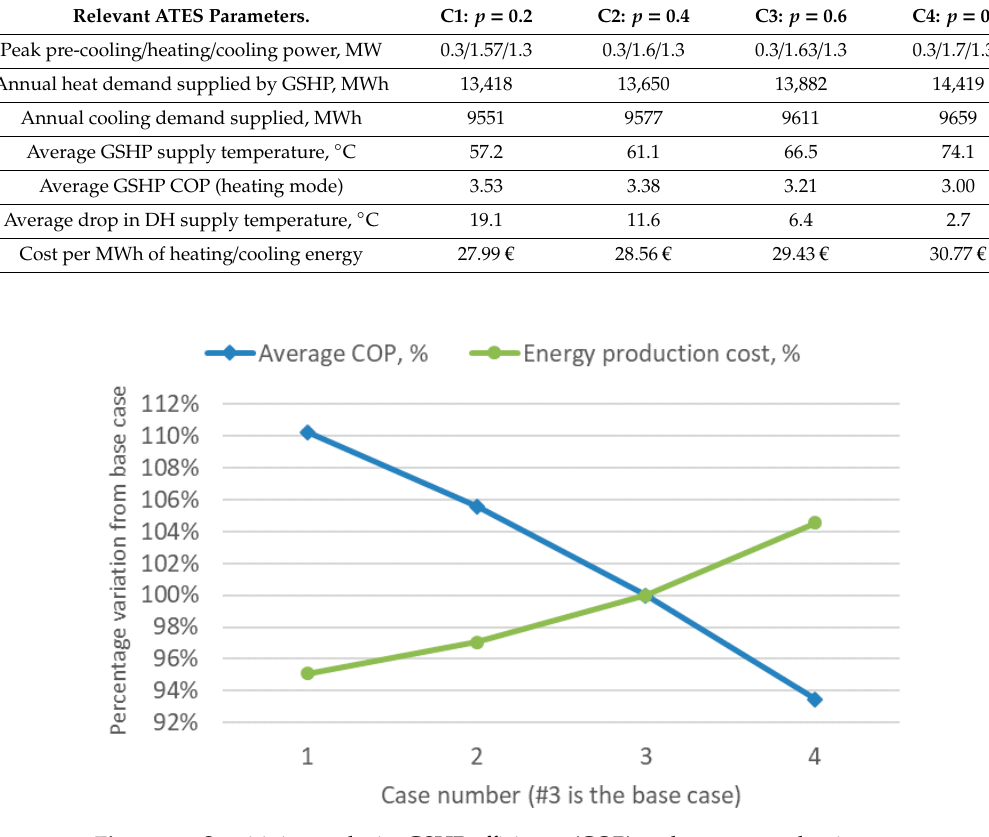
Figure 10. Sensitivity analysis: GSHP efficiency (COP) and energy production cost.